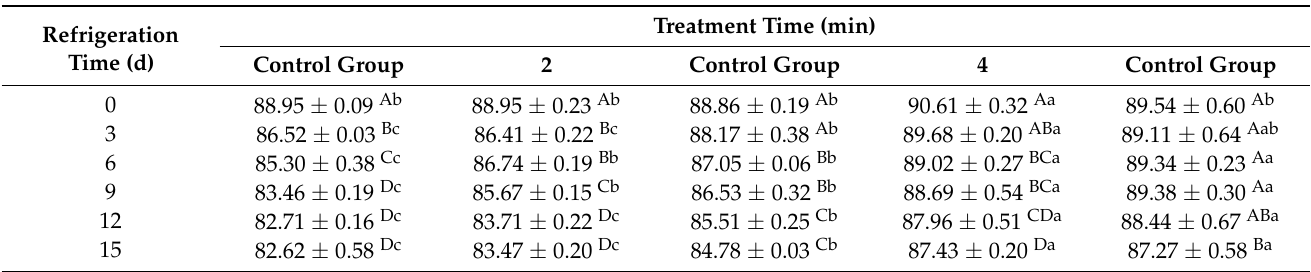
Table 3. Effect of Cold Atmospheric Plasma treatment at 50 kV voltage for different treatment times on the luminosity of hairtail samples during cold storage conditions.